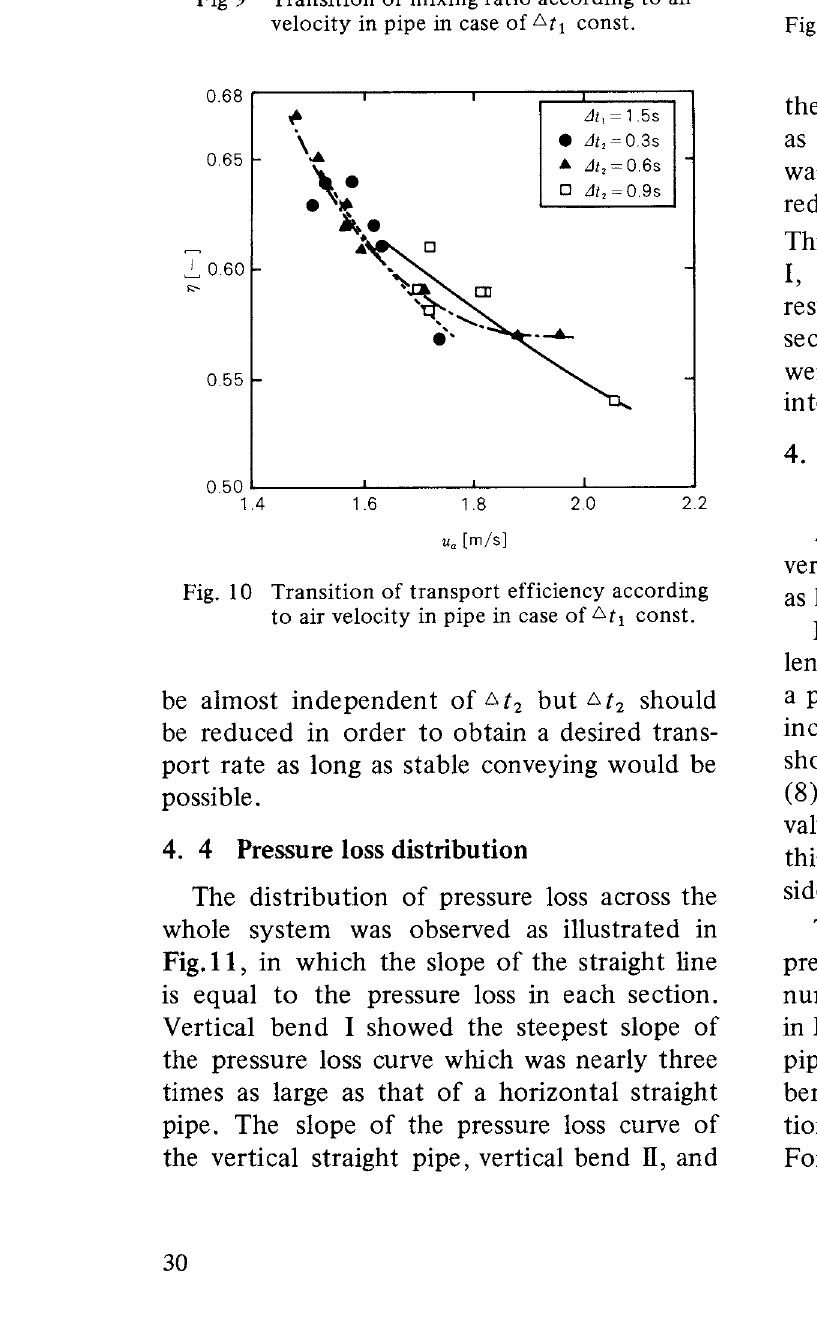
Fig. 11 Diagram of pressure drop along the pipe length